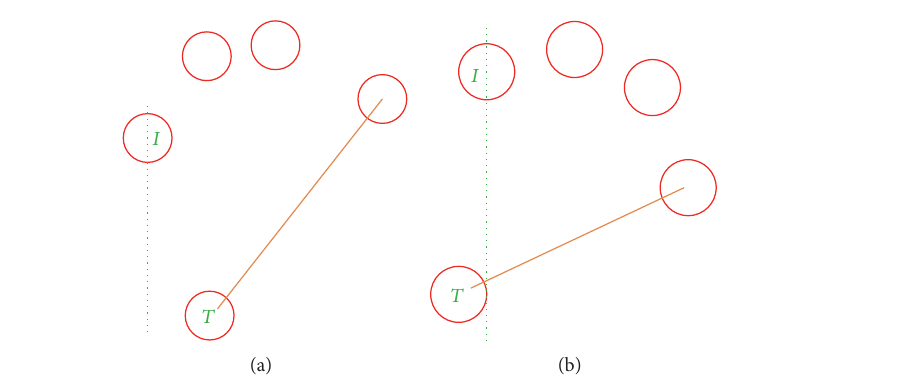
Figure 4: The device orientation definition.